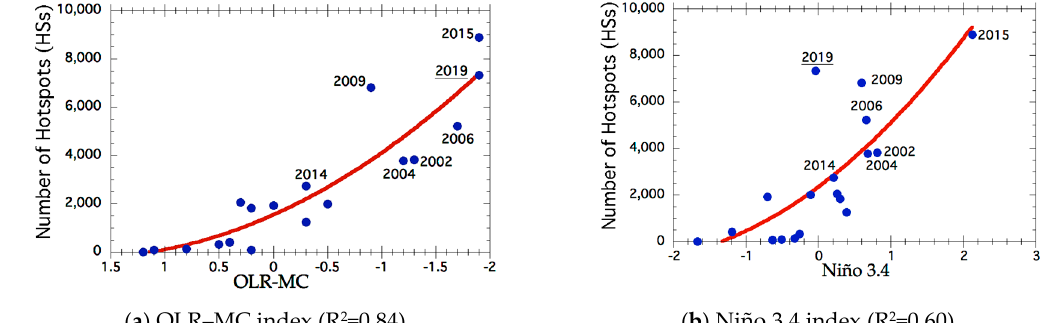
Figure 4. Comparison of OLR–MC and Niño 3.4.